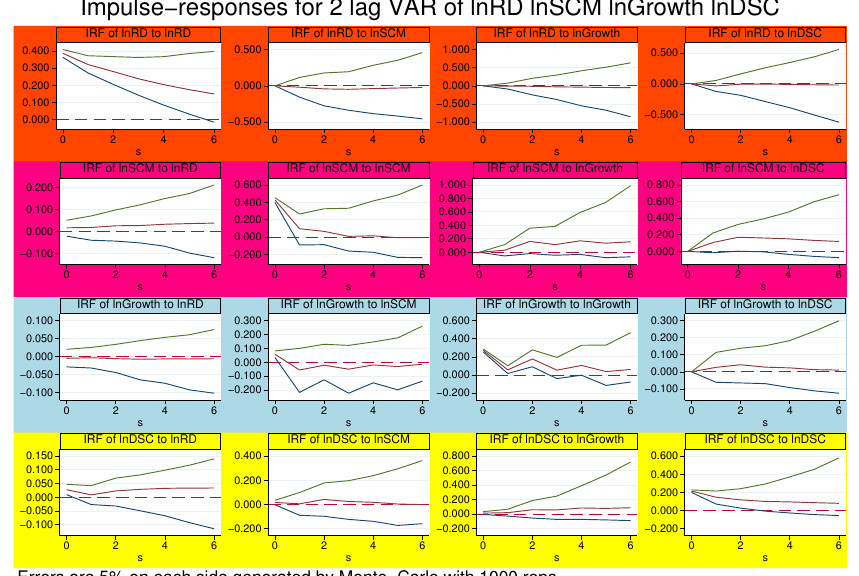
Figure 7. The first row (in orange) indicates, respectively, the impulse response of R&D innovation to itself (lnR&D), supply chain management (lnSCM), growth capacity, and debt servicing capacity (lnDSC); the second row (in magenta) indicates, respectively, the impulse response of supply chain management to R&D innovation (lnR&D), itself (lnSCM), growth capacity (lnGrowth), and debt servicing capacity (lnDSC); the third row ( in light blue) indicates, respectively, the impulse responses of growth capacity to R&D innovation (lnR&D), supply chain management (lnSCM), itself (lnGrowth), and debt servicing capacity (lnDSC); the fourth row (in yellow) indicates, respectively, the impulse responses of the debt servicing capacity to R&D innovation (lnR&D), supply chain management (lnSCM), growth capacity (lnGrowth), and itself